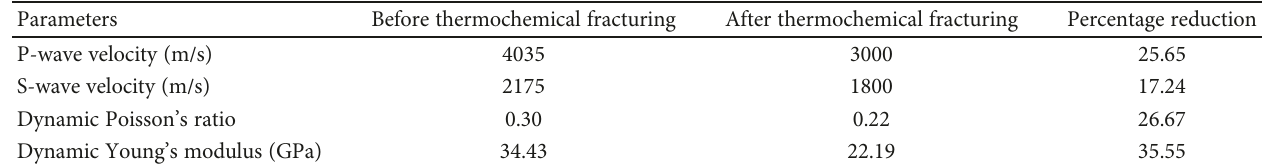
Figure 16: Comparison of continuous strength pro fi les of the 4-inch cement block sample before and after performing thermochemical fracturing. Table 4: Comparison of ultrasonic velocities, dynamic Poisson ’ s ratio, and dynamic Young ’ s modulus before and after thermochemical